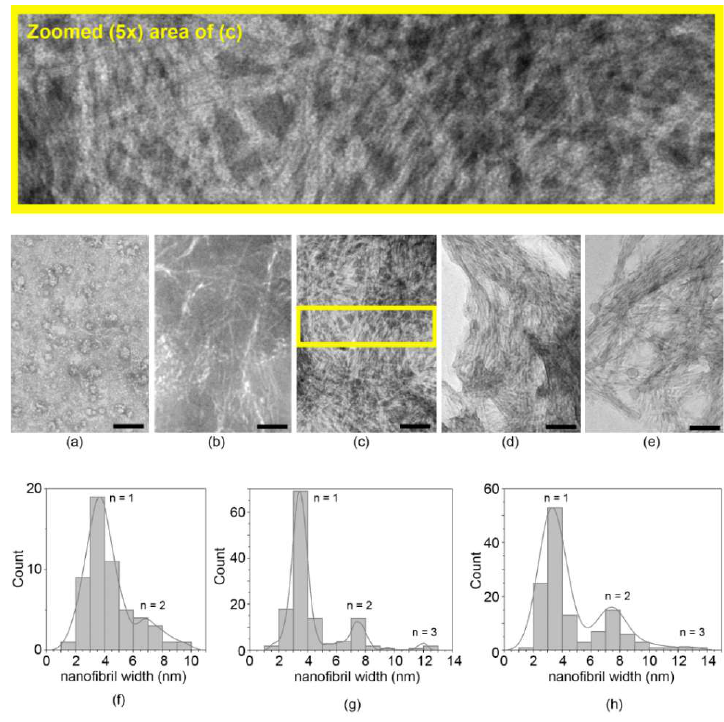
Figure 1. TEM analysis of peptide samples at various concentrations: ( a ) 0.05 mM; ( b ) 0.1 mM; ( c ) 1